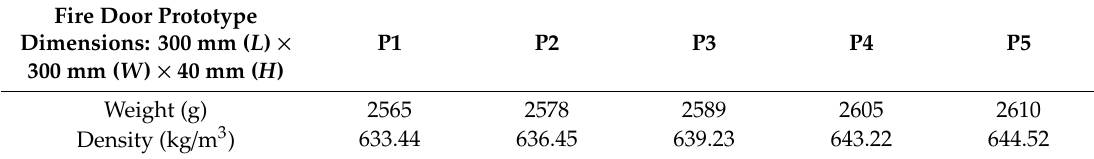
Table 2. Details of experimental